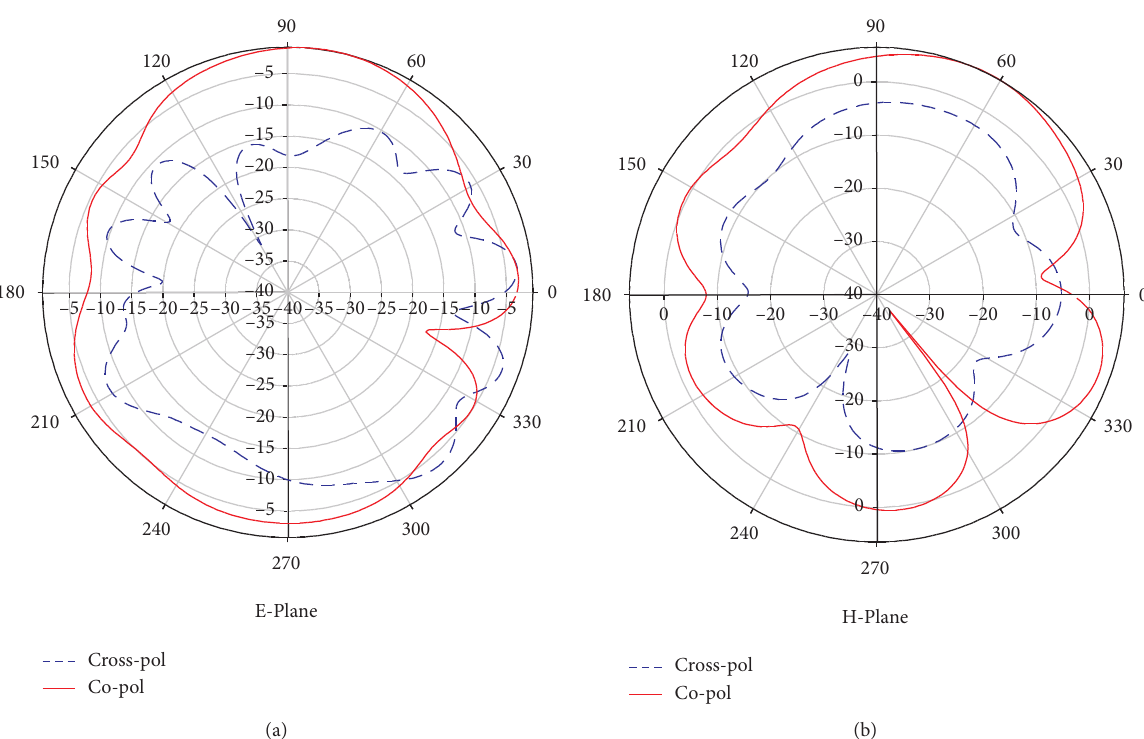
Figure 17: Radiation pattern of the proposed MIMO antenna in E-plane and H-plane at